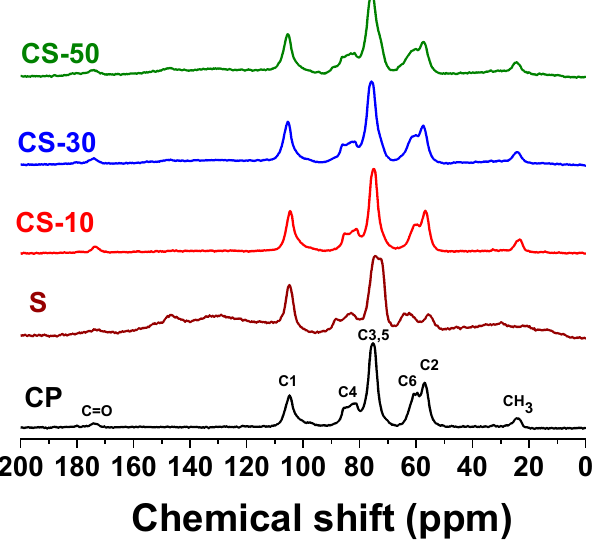
Figure 2. 13 C solid state NMR for CP, S, CS-10, CS-30, and CS-50.